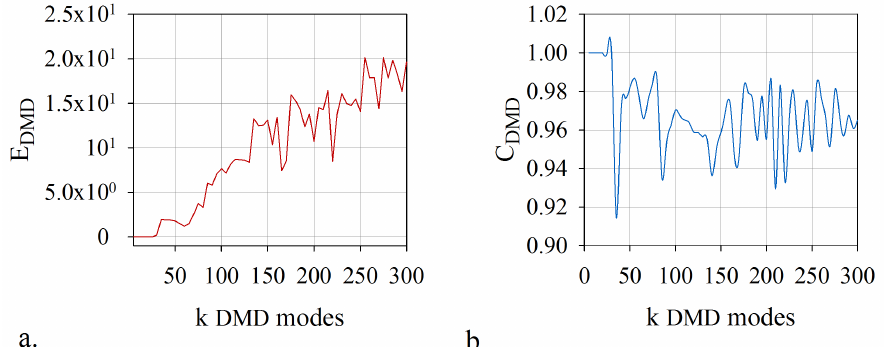
Figure 4. The case Re = 10 2 : ( a ) The relative error computed as a function of retained number of dynamic modes, ( b ) The correlation coefficient computed as a function of retained number of dynamic modes. N DMD = 15 leading modes have been selected.